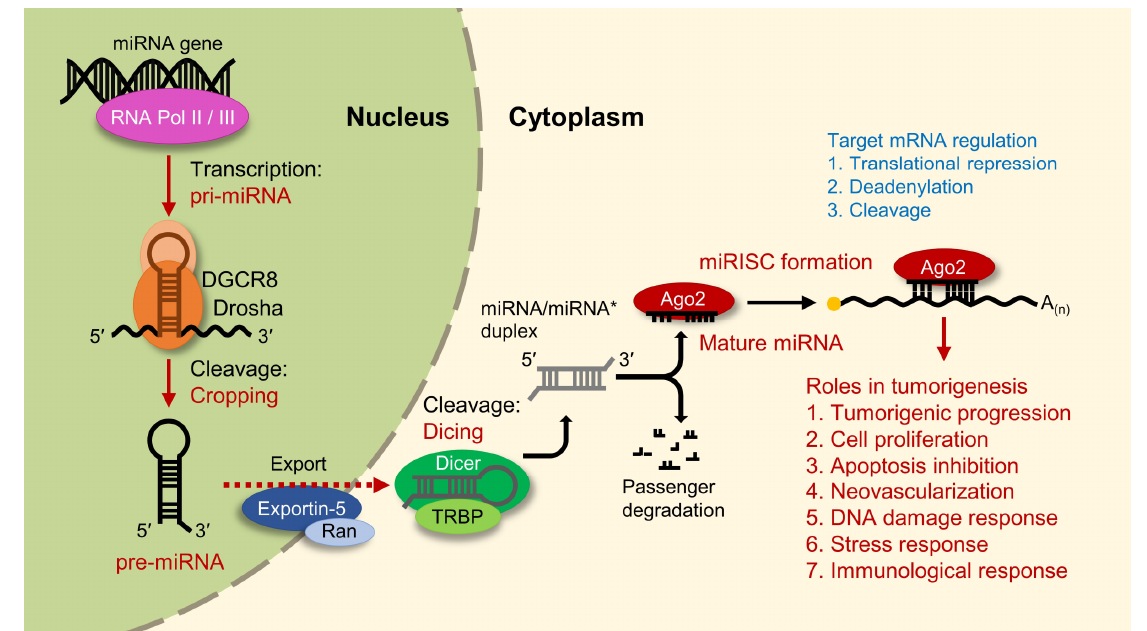
Figure 1. General miRNA biogenesis pathway and the related functions in cells; miRNA biogenesis begins with transcription by RNA polymerase II/III to create a pri-miRNA and is cleaved by Drosha/DGCR8 (cropping). The pre-miRNA is then exported to the cytoplasm via Exportin-5/Ran GTPase for further processing by Dicer/TRBP (dicing). Of this processed miRNA/miRNA* duplex, a “guide strand” is selected and loaded onto the Ago2 protein while the remaining passenger strand (miRNA*) is degraded. With the formation of a miRISC complex, target mRNA can be regulated and subsequently affect cellular and tumorigenic properties. pri-miRNA—primary microRNA, DGCR8— DiGeorge syndrome critical region 8, pre-miRNA—precursor microRNA, TRBP—transactivation response element RNA-binding protein, Ago2—argonaute protein 2, and miRISC—microRNA- induced silencing